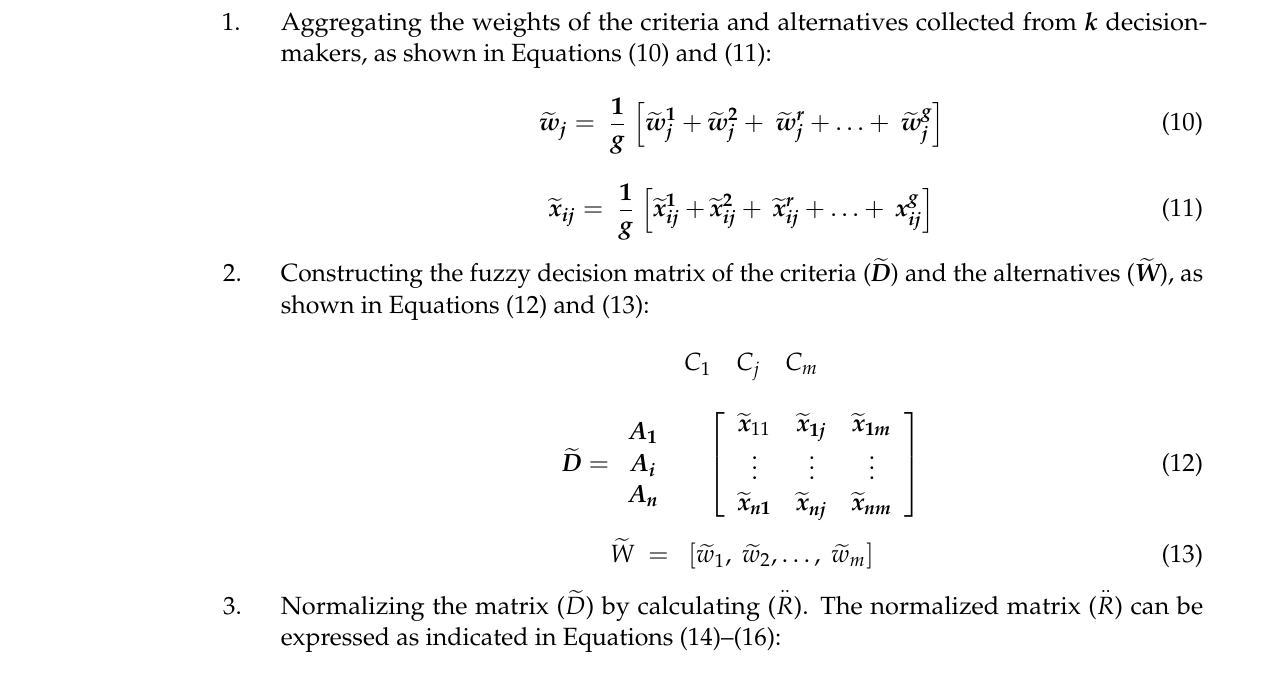
3. Normalizing the matrix ( (cid:101) D ) by calculating ( expressed as indicated in Equations (14)–(16):